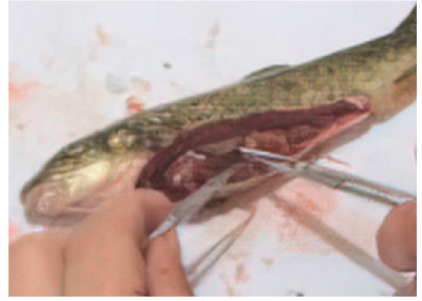
Figure 1. View of the necropsy procedure on the black barbel from the River Bregalnica. Gross lesions were not found on the body surface or in internal organs and cavities.